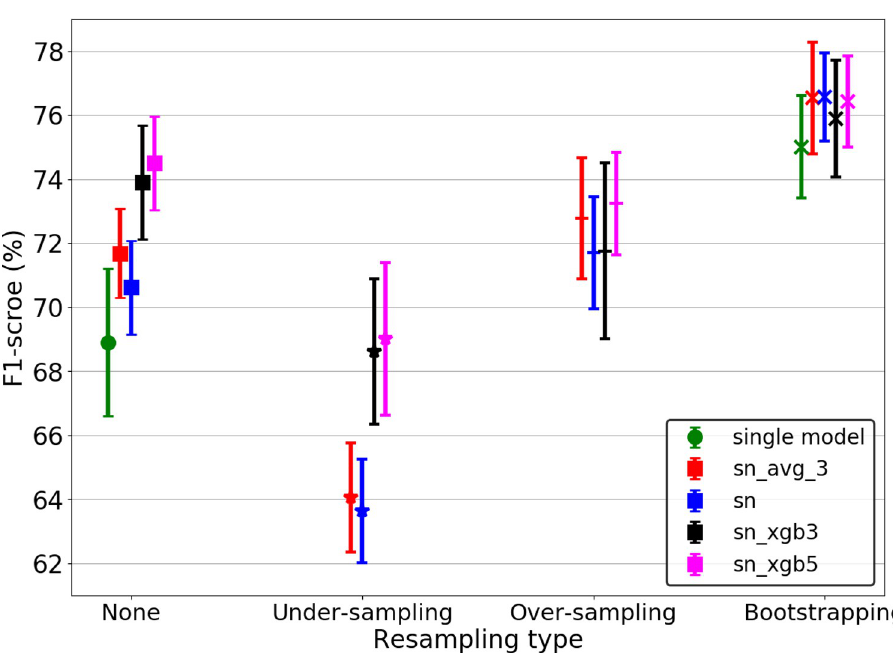
Fig 5. Performance of classifiers based on four resampling methods for four types of ensemble models. The single model performance is only displayed in two types of resampling (including ‘none’ and ‘bootstrapping’), to better understand the effect of the ‘bootstrapping’ approach on the baseline model (which is based on original data and fixed learning rate). Using snapshot ensemble-based method, for each type of resampling (including ’none’, ‘under- sampling’, ‘over-sampling’, and ‘bootstrapping’), four ensemble models have been applied to the outputs last Snapshot ensemble (‘sn’), the average prediction of the last 3 Snapshot ensemble models (‘sn_avg_3’), and combining the predictions of the last 3 (‘sn_xgb3’) and 5 Snapshot ensemble models (‘sn_xgb5’) by XGBMs. The mean ± STD of macro F1-score of test datasets over 8-fold cross-validation are shown.